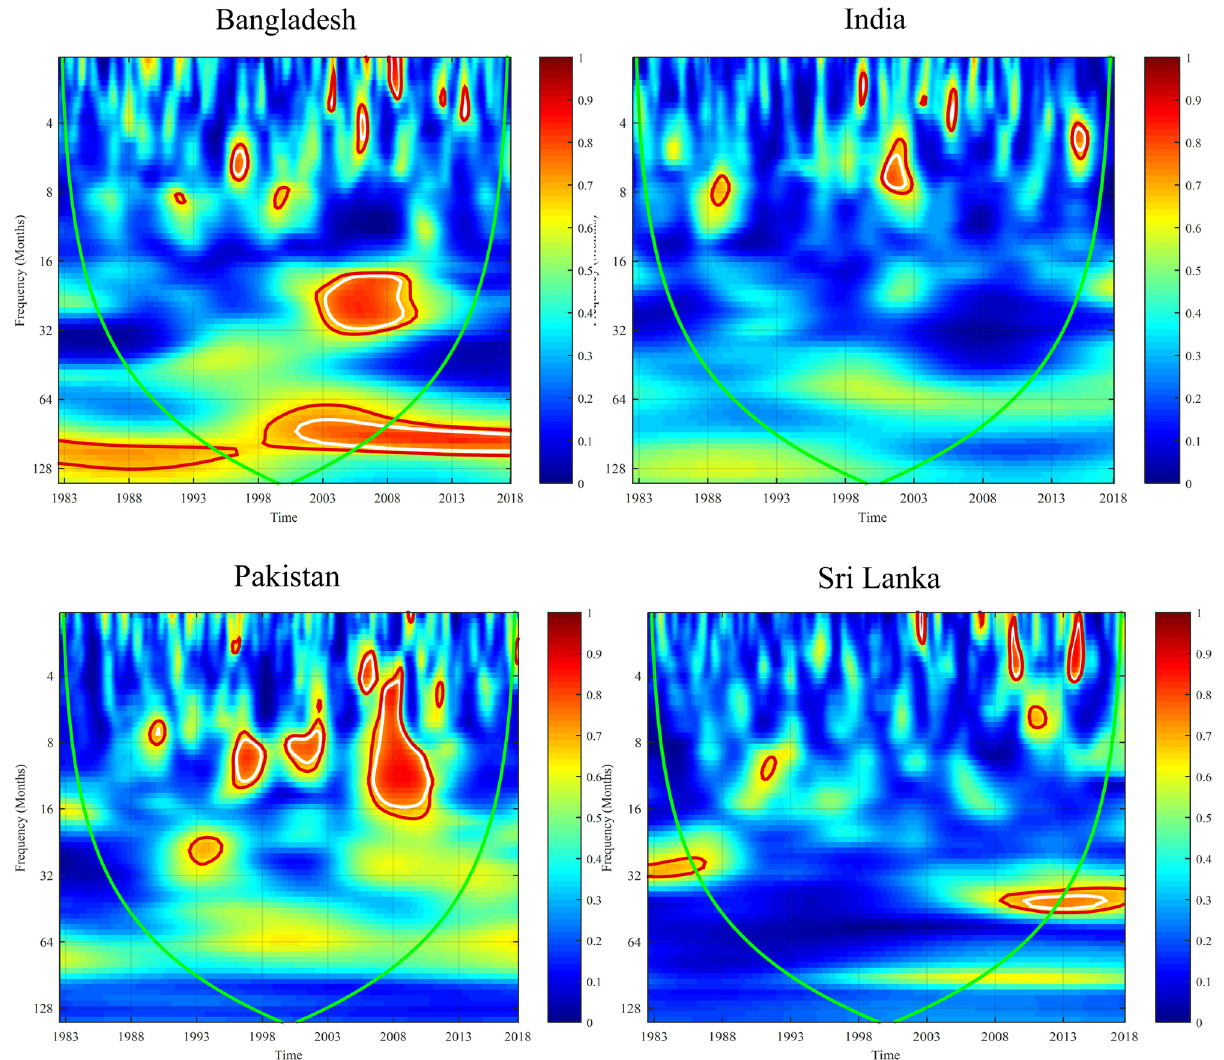
Figure 3: Wavelet - based causality from oil price to exchange rate. Note: Statistical signi fi cance at 5% ( 10% ) is shown through white ( red )